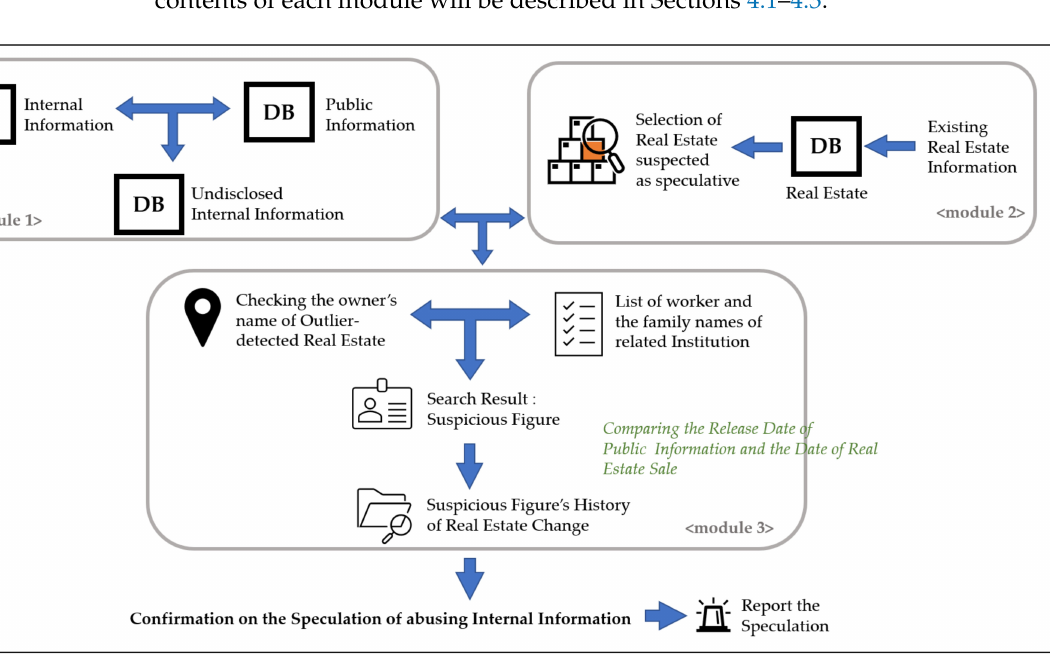
Figure 1. The Whole System of Each